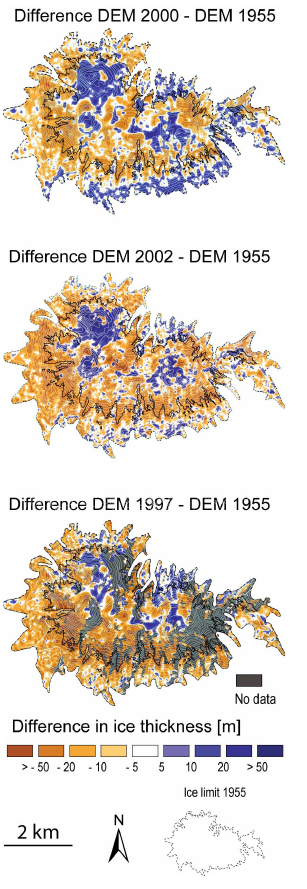
Fig. 8. Estimation of ice loss between 1955 and 2000 and between 1955 and 1997.